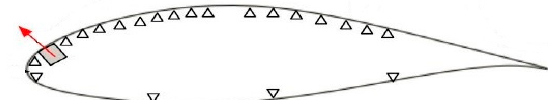
Figure 9. Wing-glove schematic with pressure tap (triangles) and actuator locations (square). (Reprinted by permission of the American Institute of Aeronautics and Astronautics, Inc. (Reston, VA, USA) from [37]).